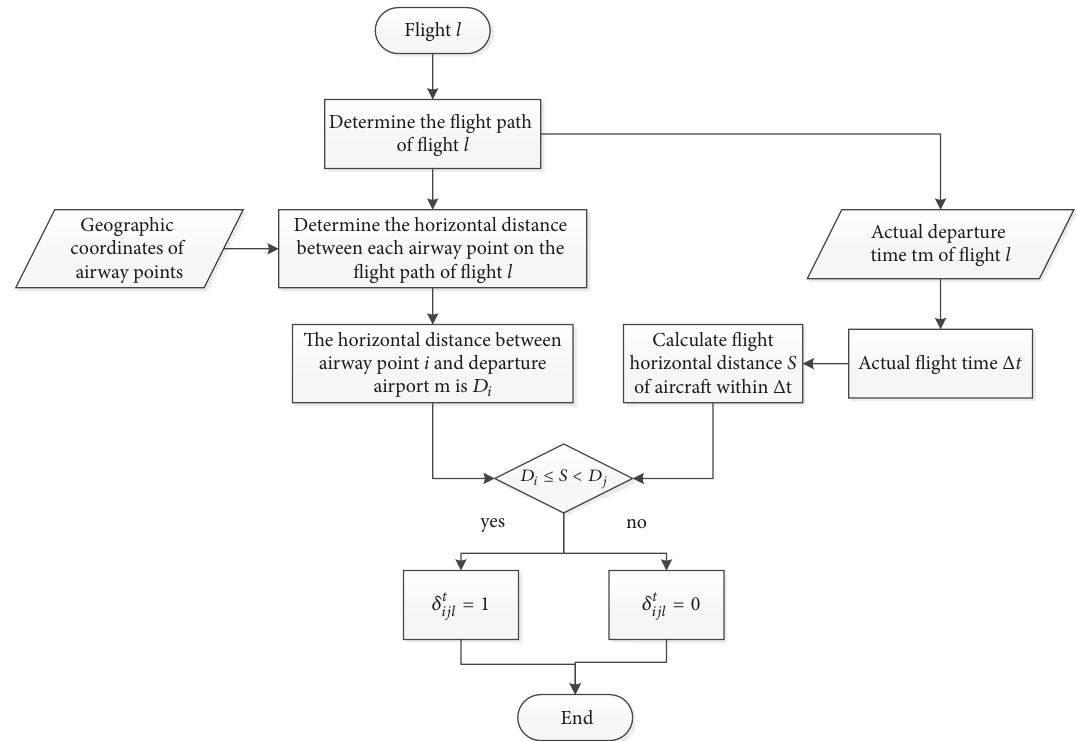
Figure 5: Algorithm flow chart of validation of 𝛿 𝑡 𝑖𝑗𝑙